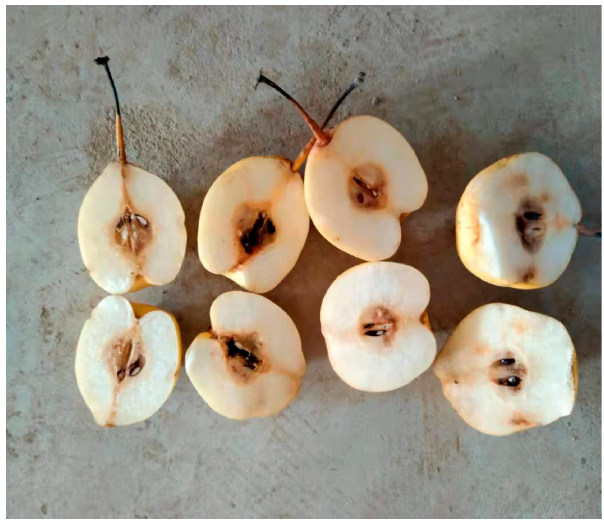
Figure 2. Photo of the internal pulp of pears with different degrees of browning.